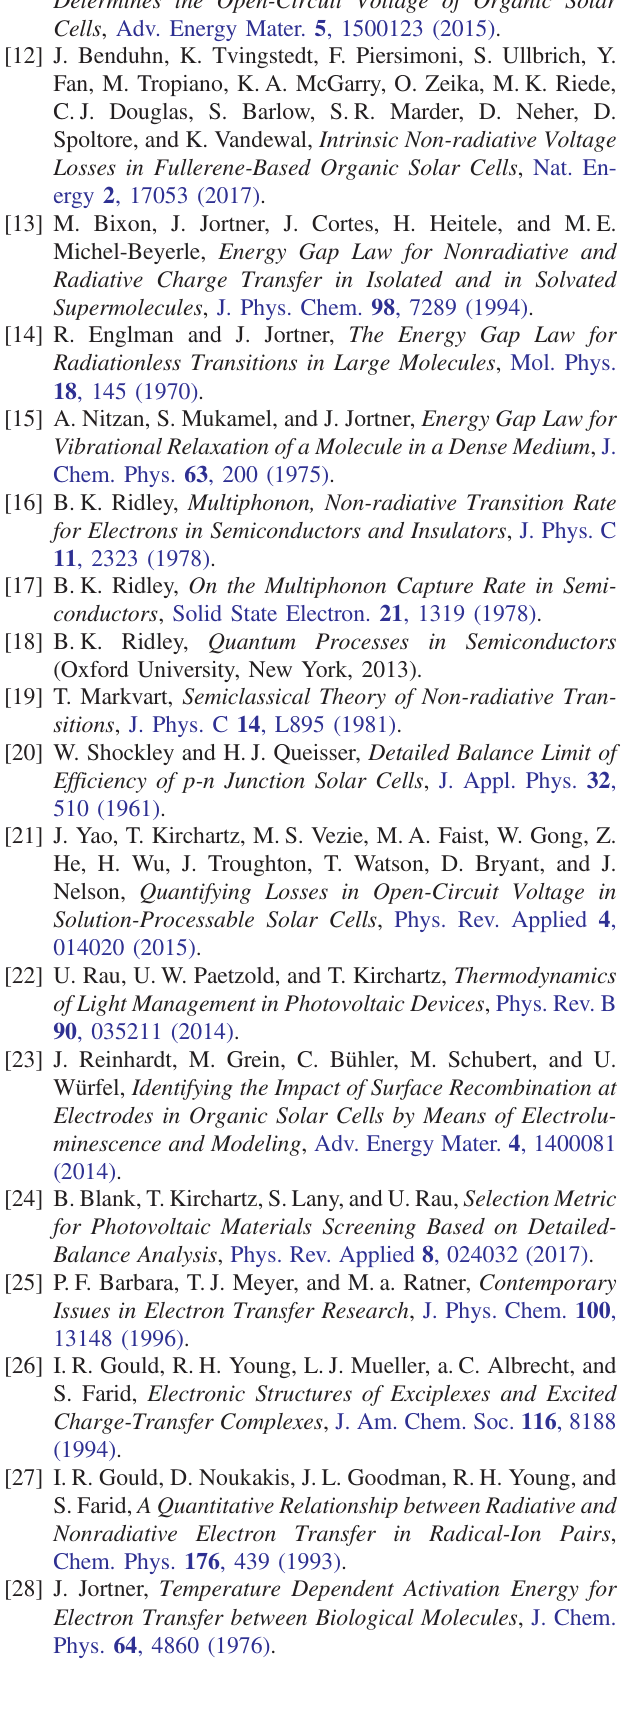
(Table S2), the detailed version of Fig. 2(d) (Fig. S1), the chemical structure of four multi-fluorine substituted oligom- ers (Fig. S2), device performance for BIT-4F, 6F, 8F, and 10F (Fig. S3 – S6), EL and EQE data for BIT-6F, 8F, and 10F (Fig. S7), experimental data for p -DTS ð FBTTh 2 Þ 2 based devices (Fig. S8), simulated EQE spectrum comparison between large and small driving force devices (Fig.